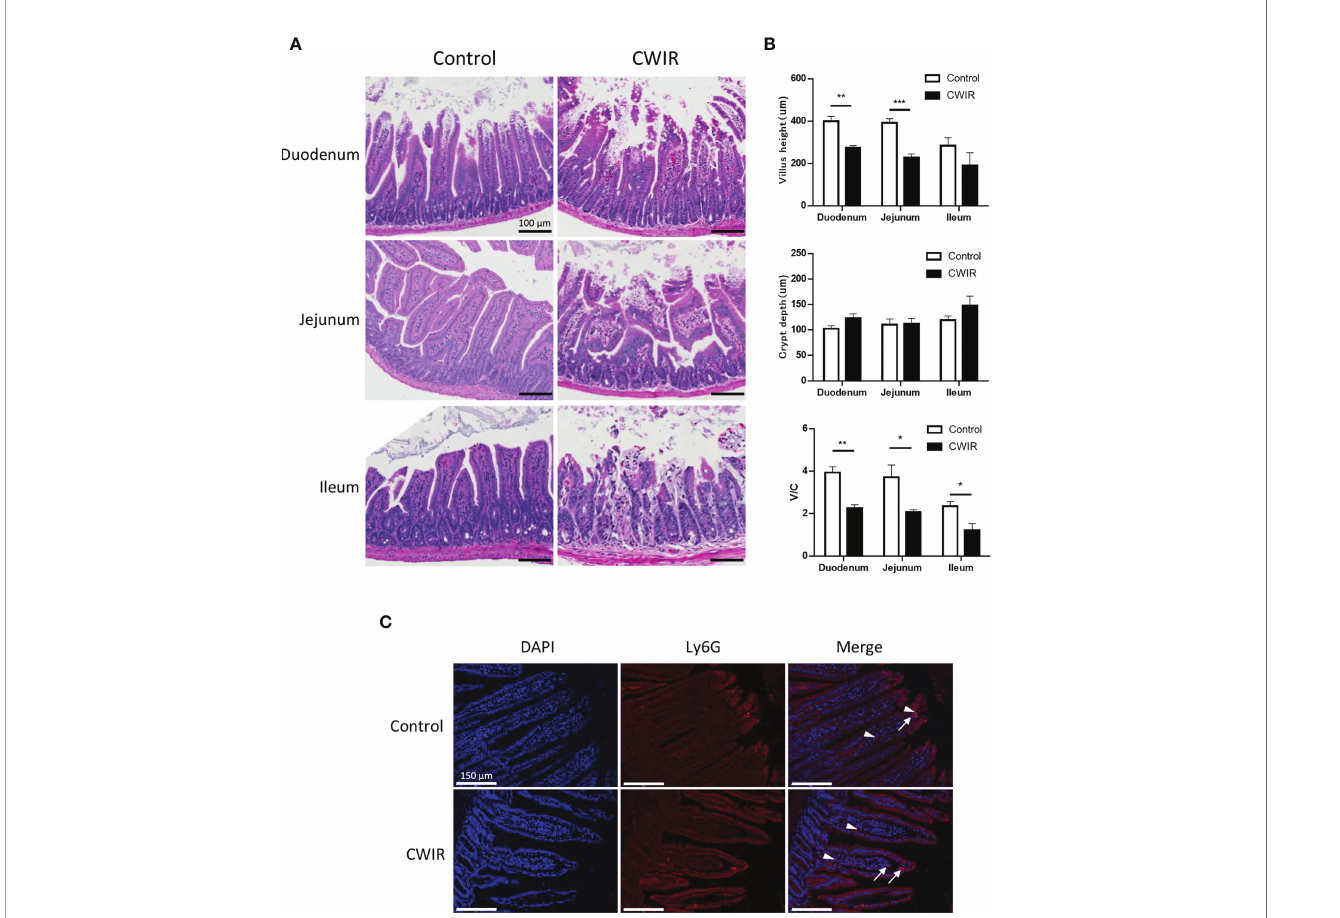
FIGURE 1 | Cold water-immersion restraint (CWIR) induces gut mucosal barrier disruption in the small intestine in mice. Different segments of the small intestine were harvested 1 h post CWIR. (A) Hematoxylin – eosin (HE) staining of mouse intestinal tissues (magni fi cation, 200×). Microscopic examination of the small intestinal mucosa revealed marked villous thinning, shrinkage, and disorganization in CWIR mice. Scale bar = 100 m m. (B) Villus height, crypt depth, and the villus/crypt (V/C) ratio were measured in the duodenum, jejunum, and ileum in mice after CWIR administration or control. All data are shown as mean ± SEM (n = 4 – 5 per group). * P < 0.05, ** P < 0.01, *** P < 0.001 vs. WT control. (C) Representative anti-Ly6G immuno fl uorescent photomicrographs of the duodenum. White arrow indicates intestinal neutrophil in fi ltration (Ly6G positive, red, n = 3 per group). White arrowhead depicts erythrocyte-nonspeci fi c staining, without DAPI nuclear staining. Scale bar = 150 m